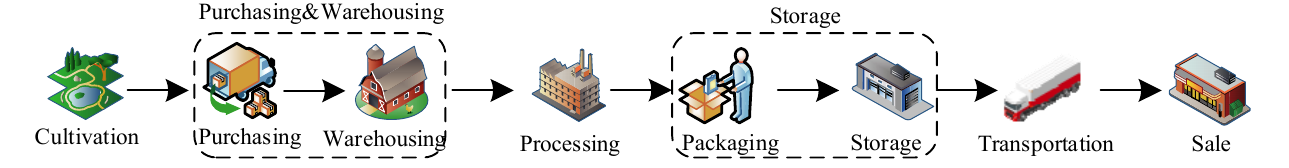
Figure 1. Grain food supply chain link process.